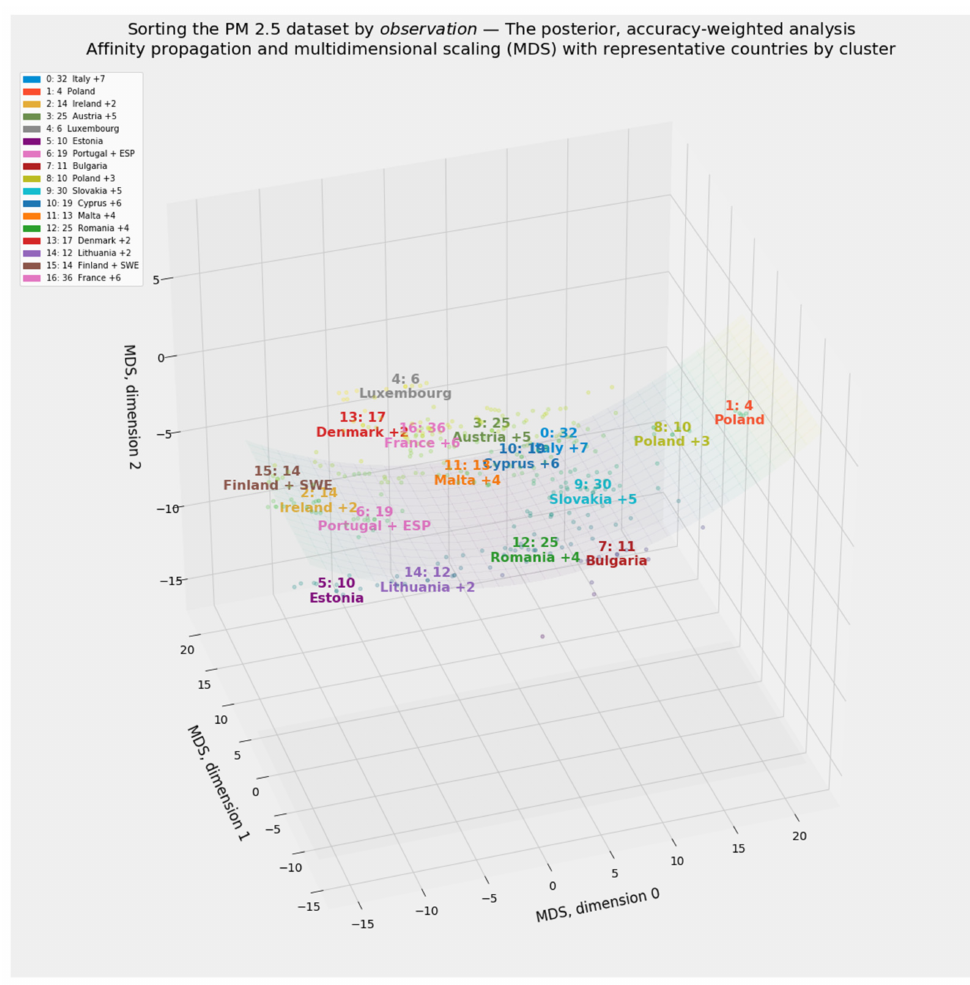
Figure 11. Clusters of observations within the “posterior” array of accuracy-weighted